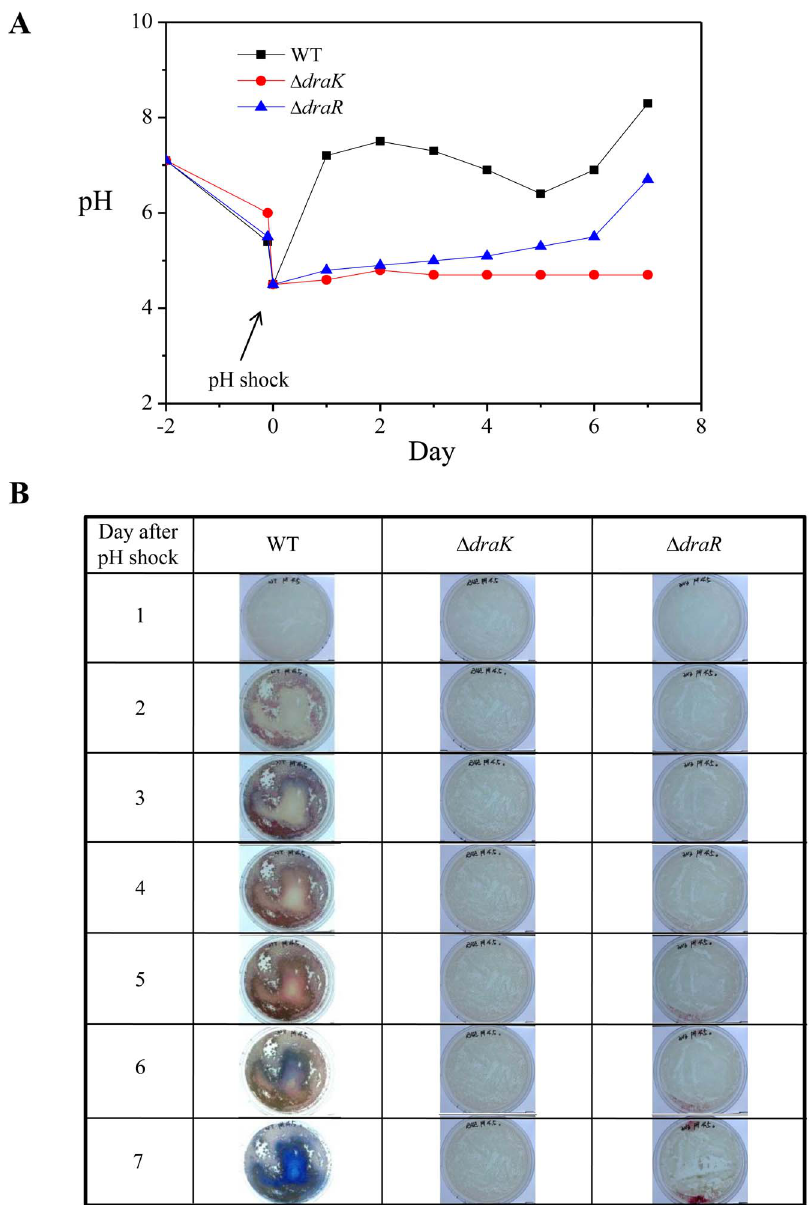
Figure 7. pH profiles and cell phenotypes. ( A ) Time-dependent pH profiles of culture plates for wild type DraK (black), the D draK mutant (red), and the D draR mutant (blue) following pH shock. ( B ) Time-dependent cell phenotypes of S. coelicolor for wild type DraK, the D draK mutant, and the D draR mutant in pH shock culture (PSC).